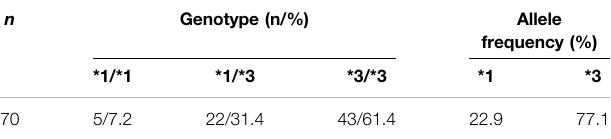
TABLE 1 | The CYP3A5 genotype distribution of renal transplant